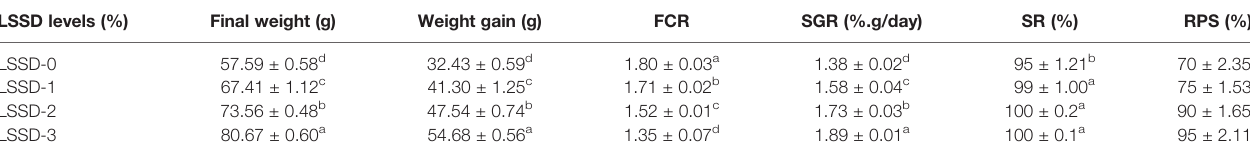
TABLE 3 | Growth performance of O. niloticus fed 0, 1, 2, and 3% diet of L. siceraria seeds supplemented diets (LSSD) for 60 days, and relative survival after bacterial challenge with A. hydrophila for 10 days. LSSD levels (%)